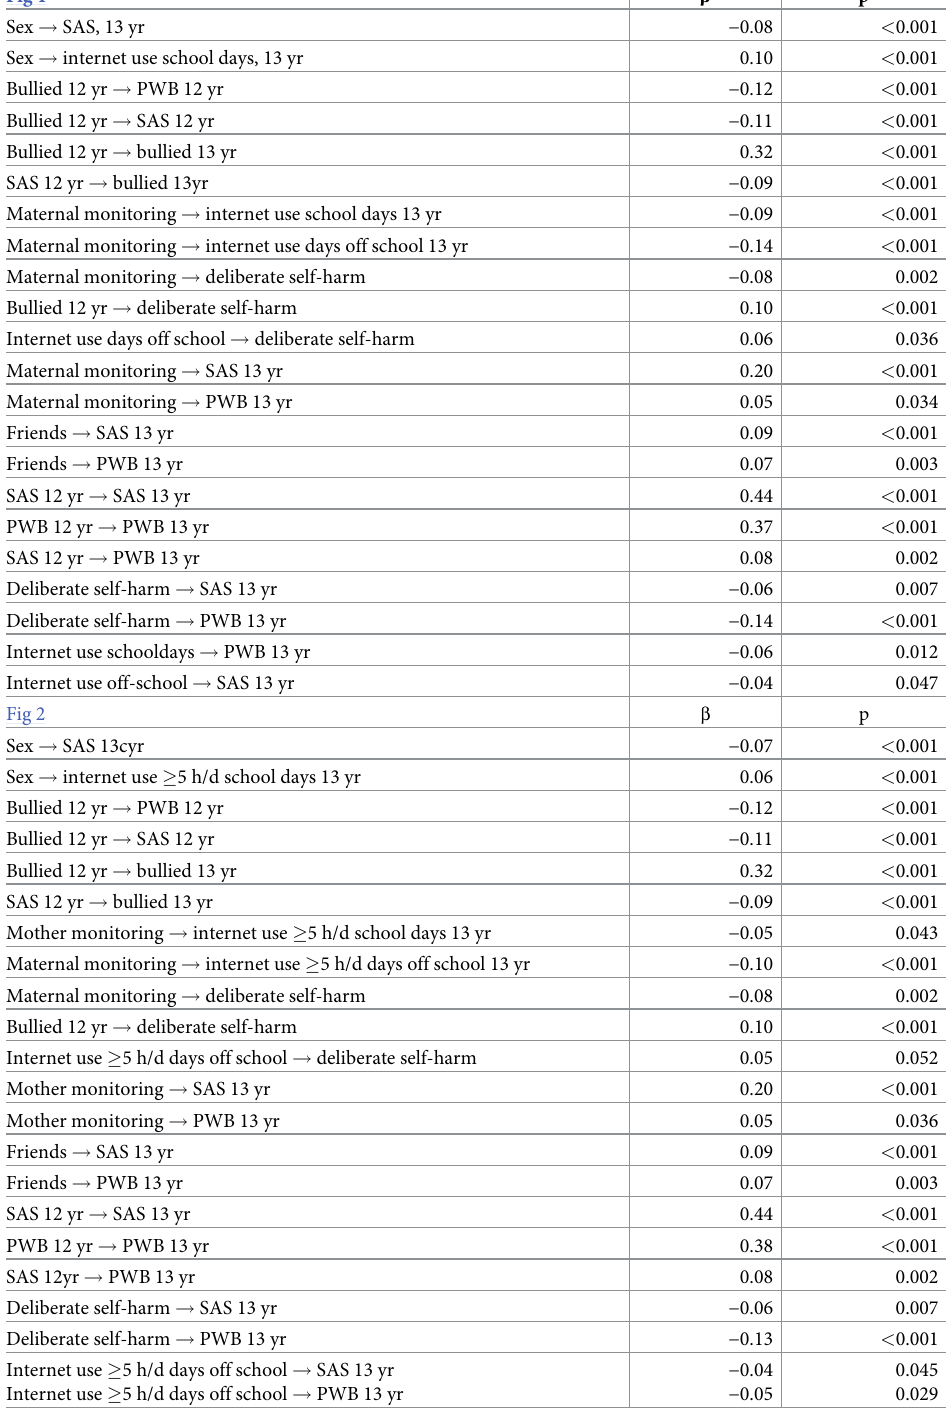
Table 3. Structural equation modeling of association among maternal monitoring, bullying, internet use, deliber- ate self-harm and self-perceived happiness (Fig 1), and internet use (Fig 2). Fig